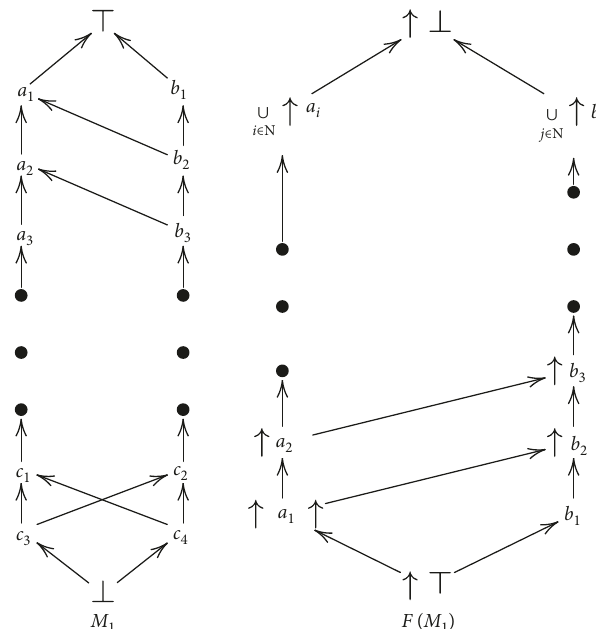
Figure 1: Multilattice M